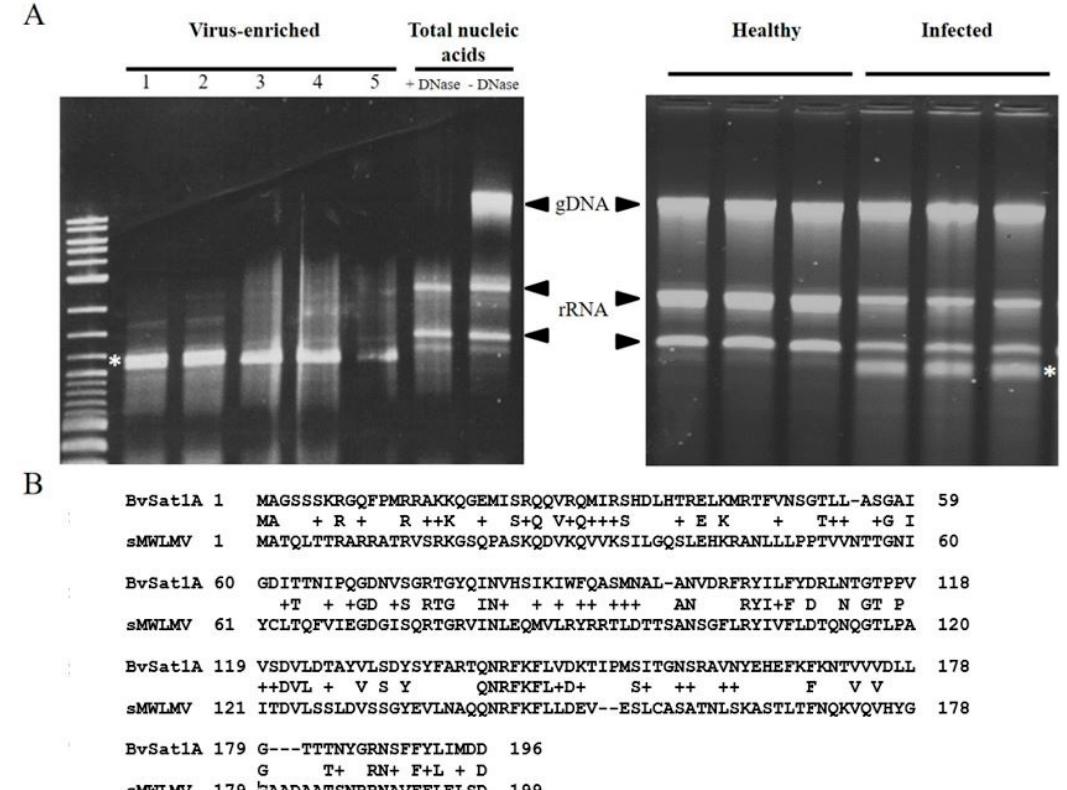
Figure 5. Identification of an abundant satellite virus in sugar beet through virus enrichment and RNAseq. ( A ) Total RNA of healthy sugar beet roots exhibit rRNA and genomic DNA after agarose gel electrophoresis (left panel, -DNase), which can be cleared of DNA ( + DNase) prior to RNAseq. Virus enrichment of several infected root samples derived from soils from locations in Minnesota (A, lanes 1–5) results in the persistence of an abundant RNA species of ~1.2 kb present as an apparent doublet band. In the right panel, a high abundance of the satellite virus (*) is evident after agarose gel electrophoresis of total (un-enriched) RNA from healthy and infected plants. ( B ) The single major ORF on the RNA was translated in silico, and the predicted AA sequence (BvSat1A) aligned to that of satellite MWLMV (sMWLMV), the closest relative to the putative novel sugar beet satellite virus in the Genbank